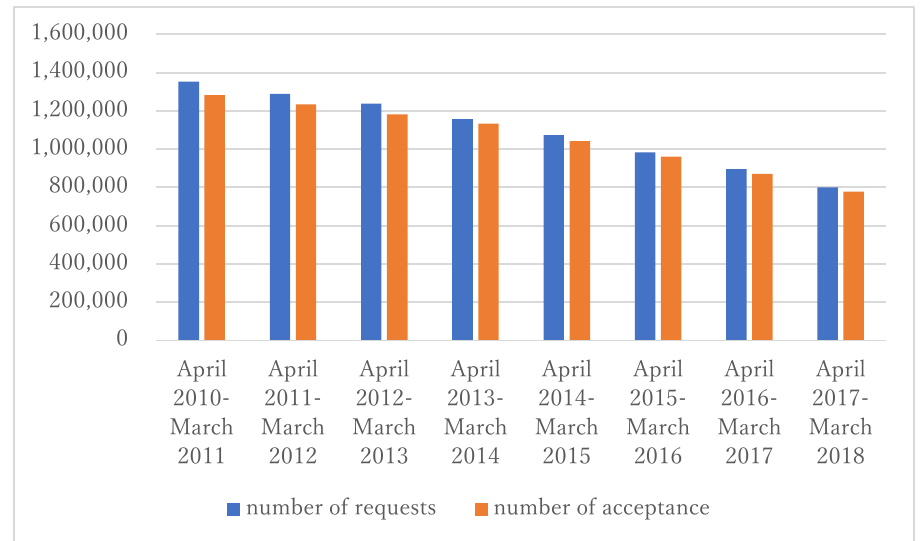
Figure 3. Number of requests by small and medium-sized enterprises (SMEs) and acceptance by banks. This figure shows the number of requests by SMEs to restructure their loans and the number of those that were accepted by banks during each fiscal year. Source: Financial Services Agency of Japan (2018).